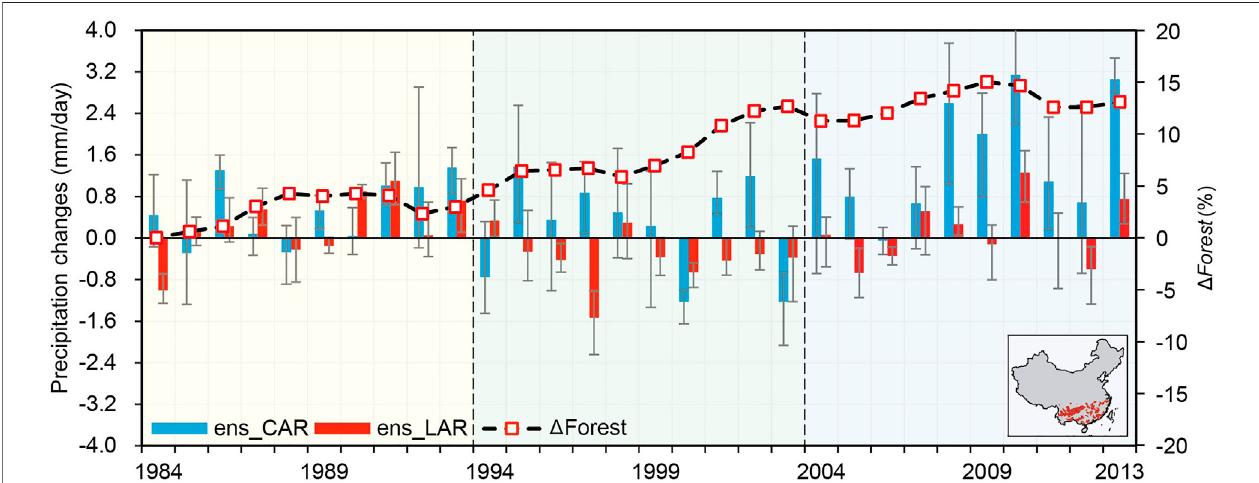
FIGURE 6 | The interannual variations (bars) in the regional means of LUCC-induced changes in CAR (red) and LAR (blue) during POF season, units: mm/day, the corresponding uncertainties (error bars) and the intensity of forests (dash lines) over southern China. Note that the precipitation changes are corresponding to the y -axis ontheleft.Thedashlineswithredhollowsquaredenote Δ Forest ( “ Δ ” denotesTRANSminusFIXED),correspondingtothe y -axisontheright,units:%.Theerrorbarsare represented by the ensemble spread of the precipitation changes due to LUCC. The meaning of subplot at the bottom right corner is the same as Figure 3A . The differenttranslucentbackgroundsinthe fi gureindicatedecadeswithdifferentLUCCintensities(lightyellow:1984 – 1993;lightgreen:1994 – 2003;lightblue:2004 –